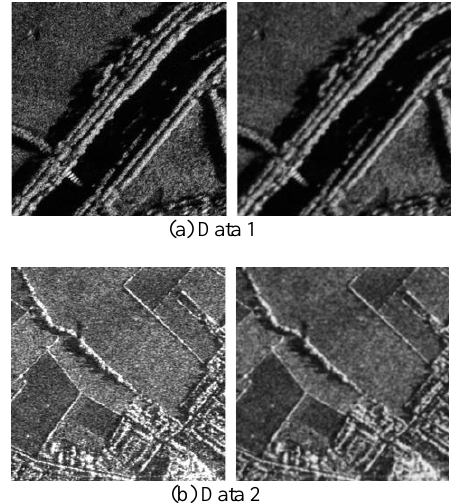
Figure 1. Original image with adaptive smoothing filtered